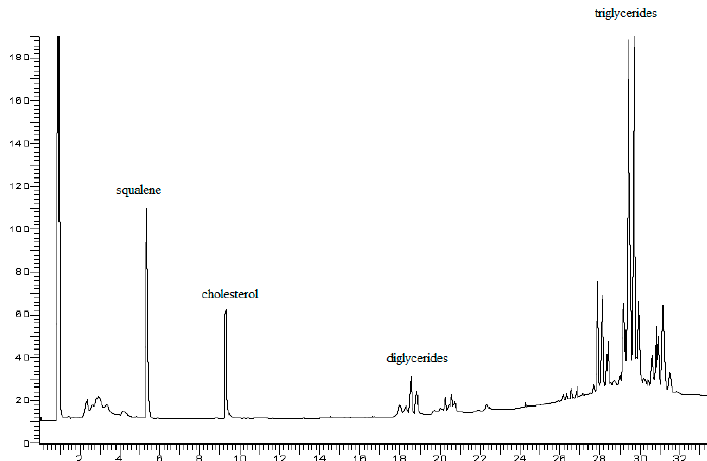
Figure 2. Gas chromatogram of fat extracted from lyophilized egg yolk with the addition of squalene as an internal standard (IS). Carrier flow: 1.5 mL/min.